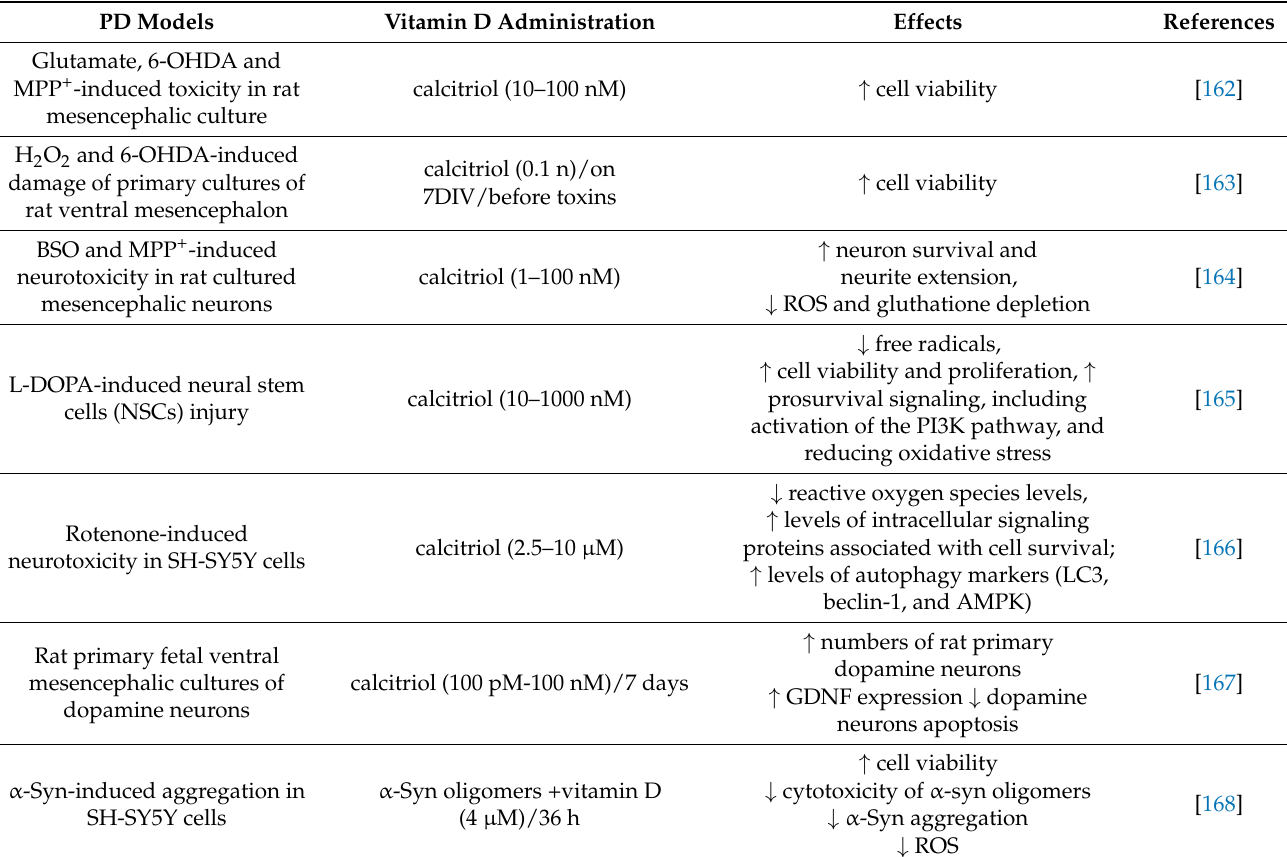
Table 3. Effects of vitamin D in experimental models of Parkinson’s disease—in vitro